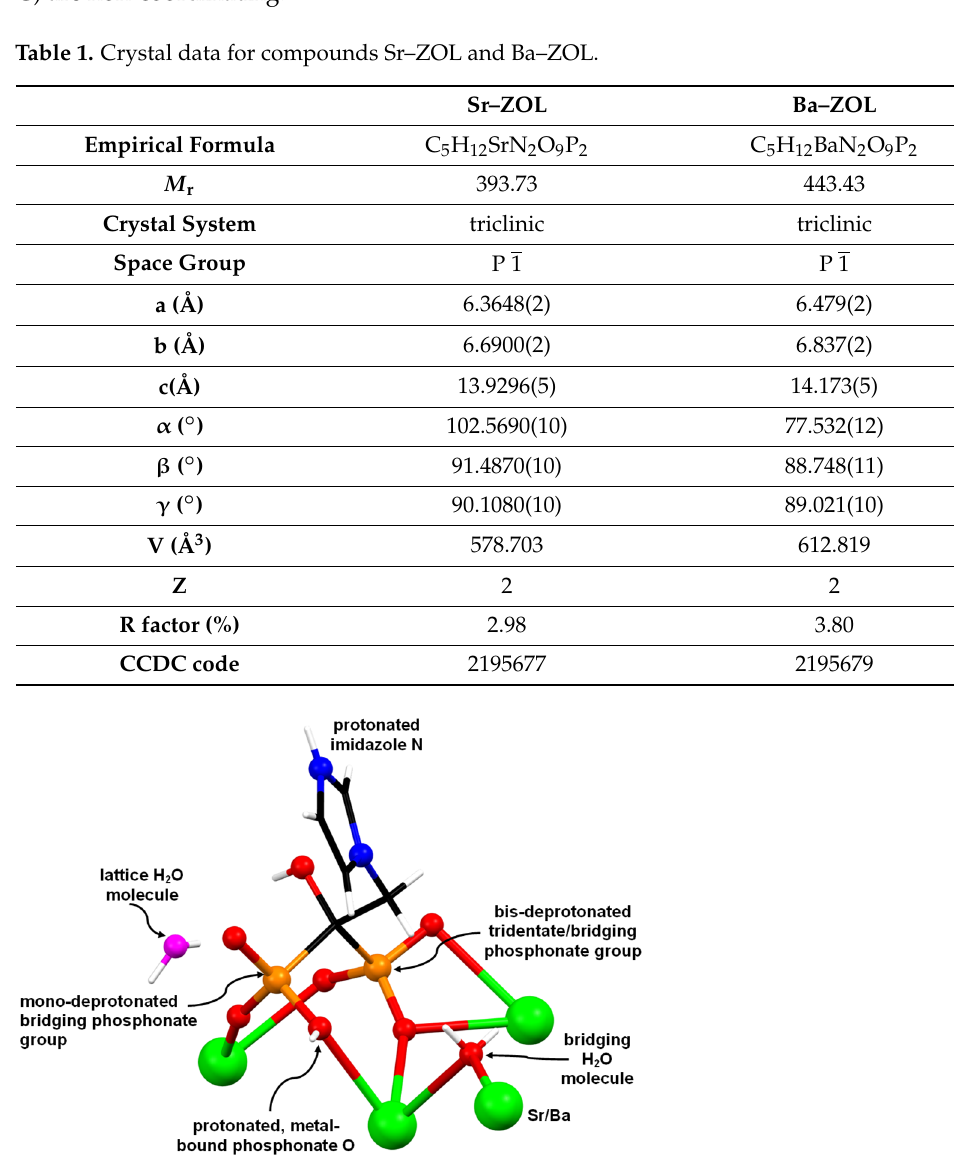
Figure 3. Depiction of the environment of the ZOL ligand in the structure of compounds Sr–ZOL and Ba–ZOL. Color codes: metal centers, green; P, orange; O, red; C, black; N, blue; H, white; lattice H 2 O, magenta.